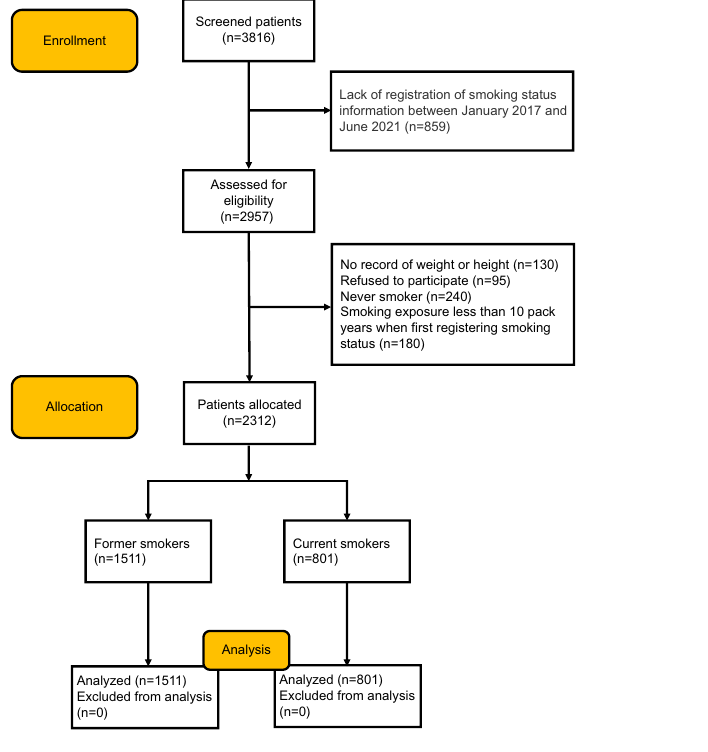
Figure 1. Flow diagram of the